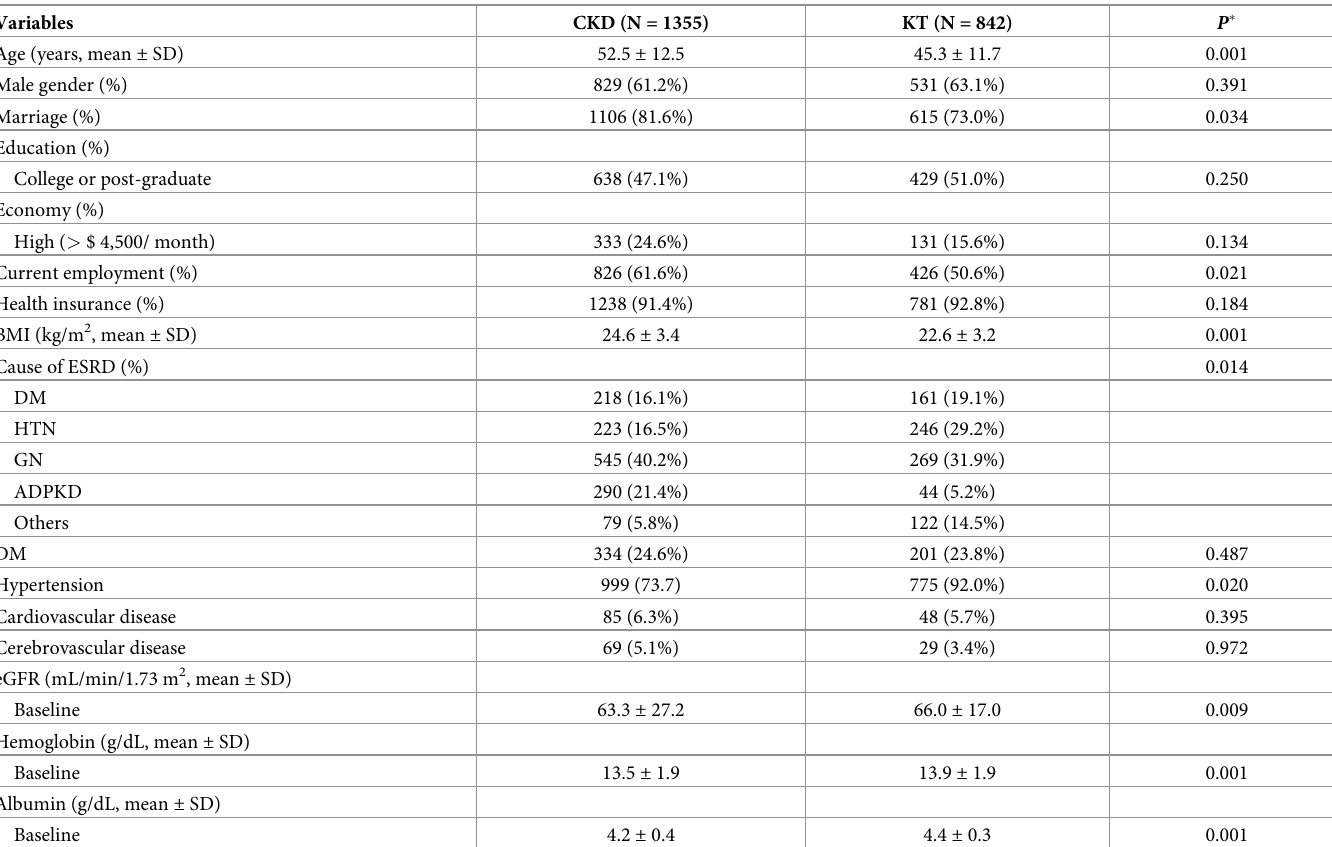
Table 1. Comparison of clinical characteristics between KT and CKD patients at